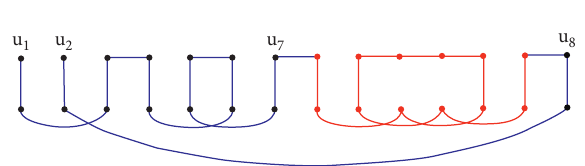
Figure 6: Type A insertion.